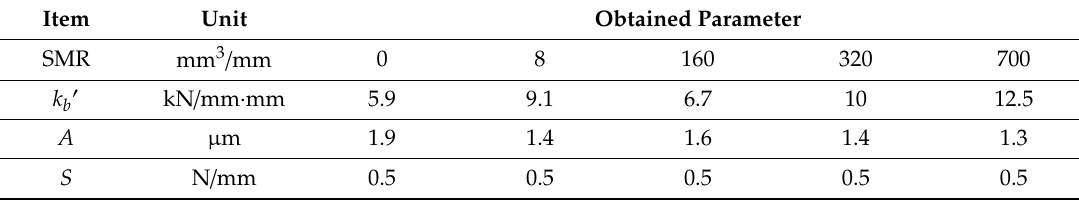
Table 5. Parameters of wheel deflection taken during specific material removal (SMR)